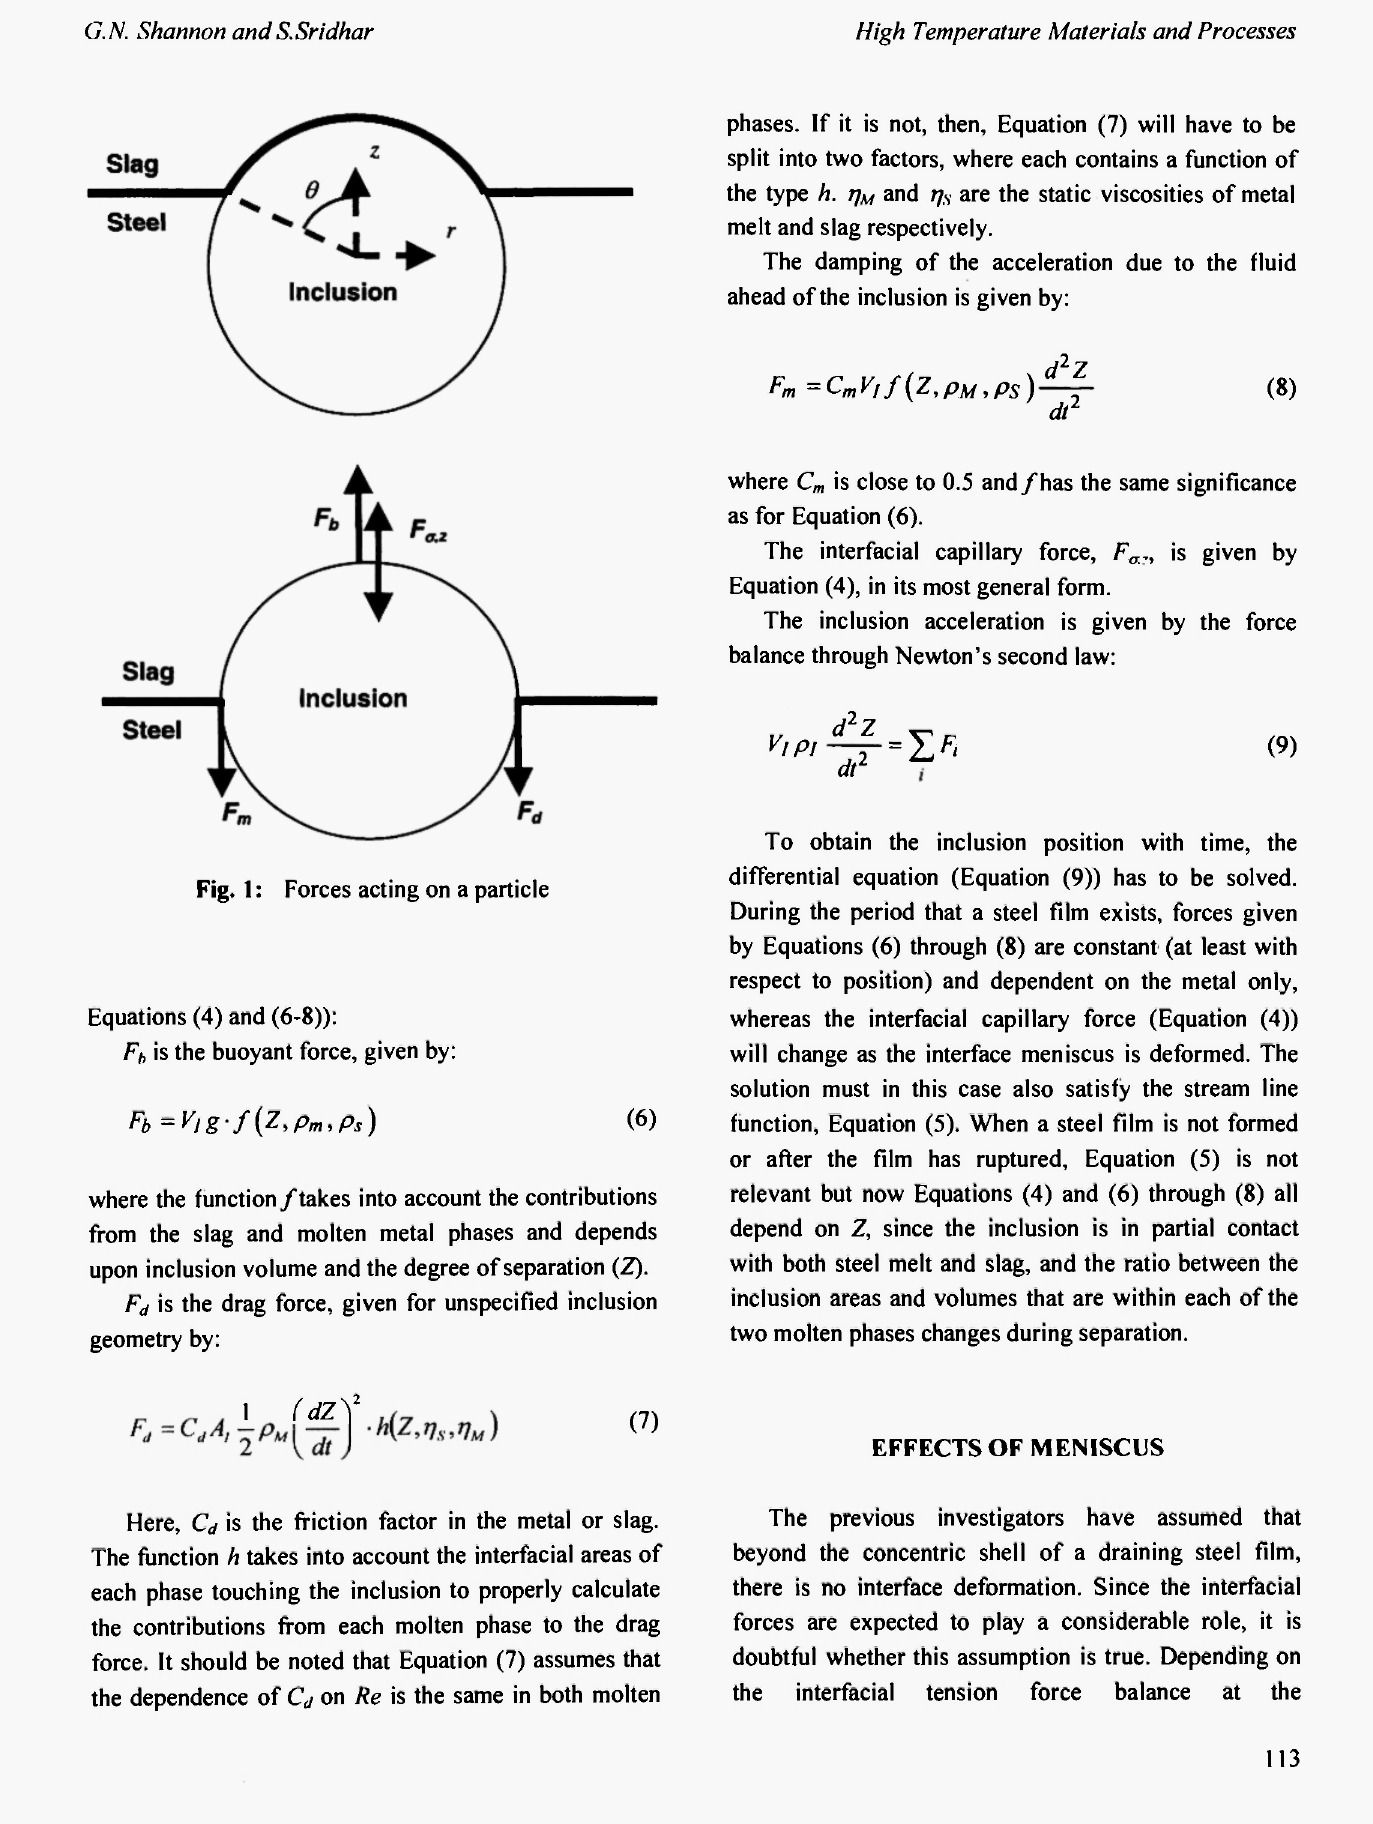
Fig. 1 : Forces acting on a